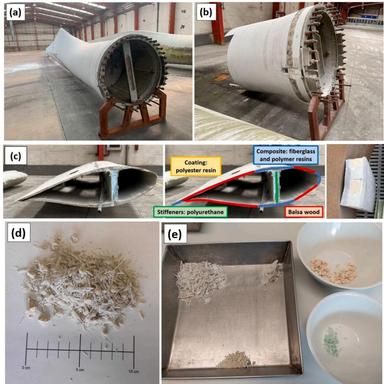
Wind-turbine blade: (a) general view, (b) starting section with metal joint; (c) generic section with component identification; (d) material resulting from the crushing of the wind-turbine blade, i.e., RCWTB; (e) separate components of RCWTB.